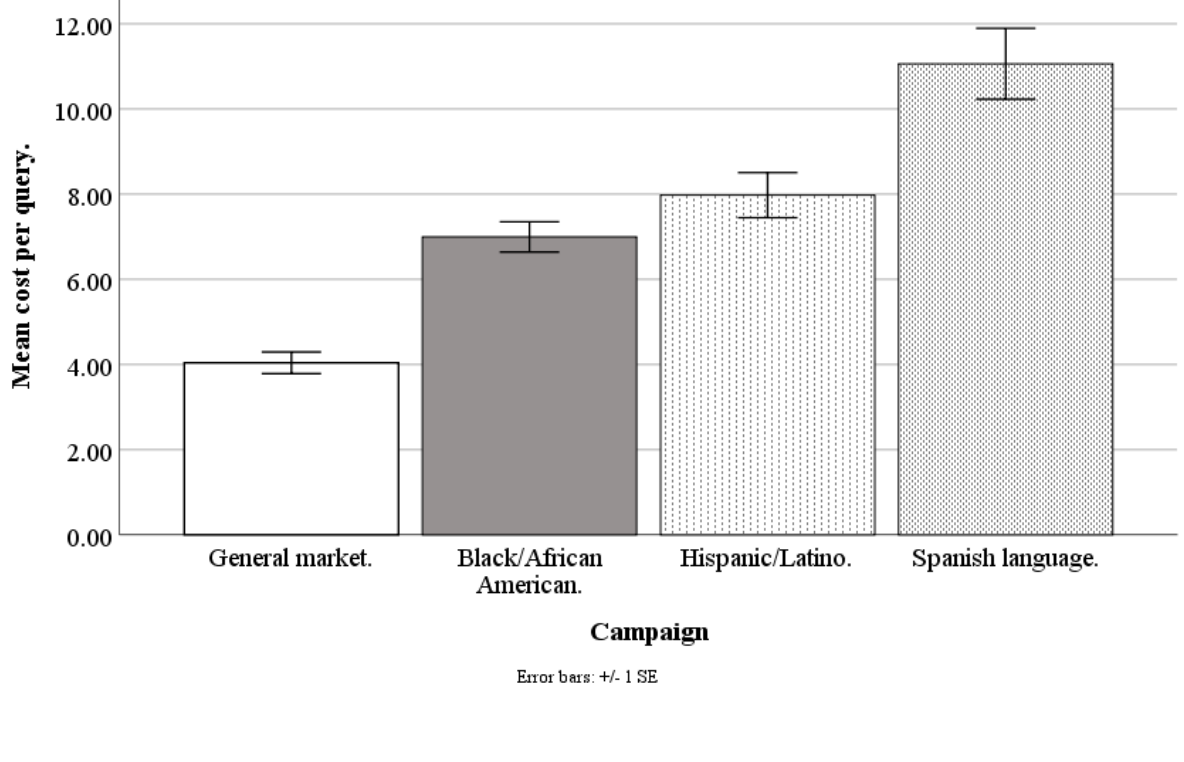
Figure 11. Mean costs per query for Facebook advertising